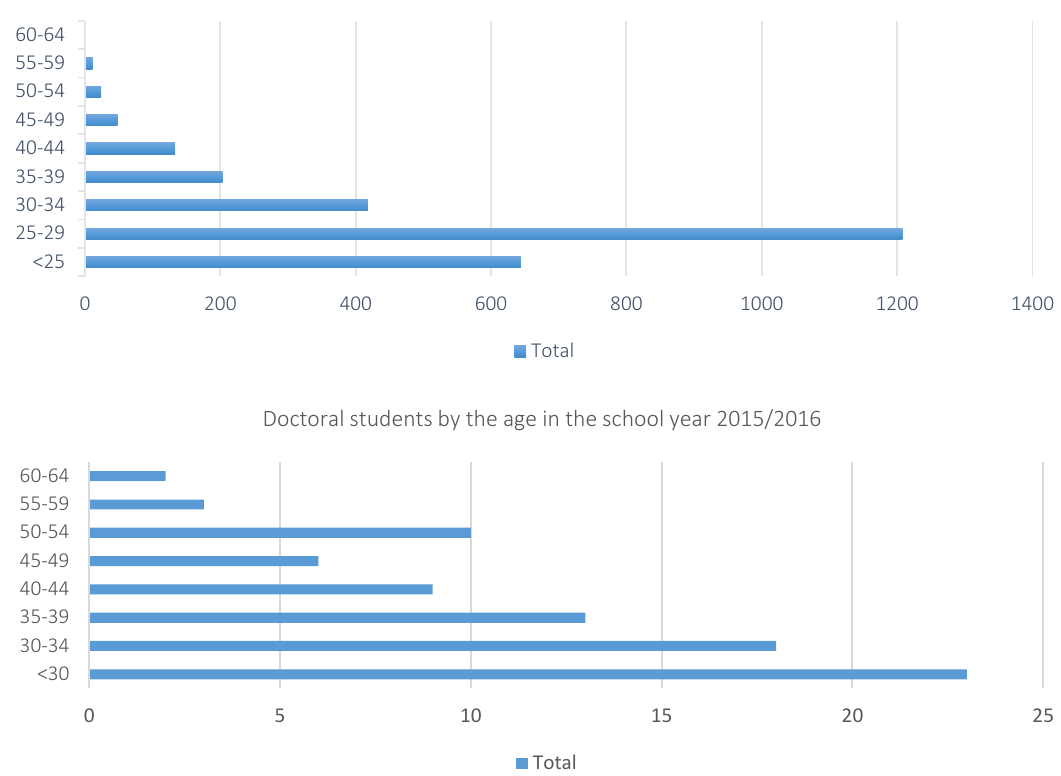
Figure 6. Enrolled in masters, specialist and doctoral studies by their